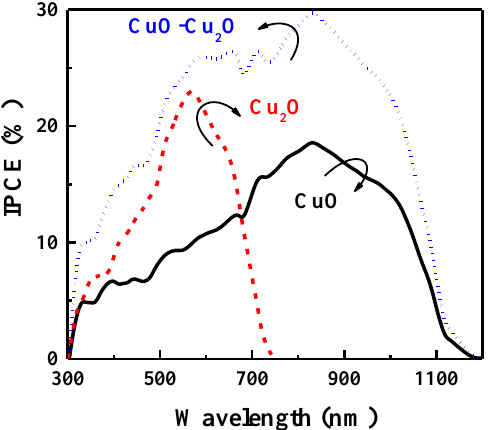
Figure 6. IPCE spectra of the CuO, Cu 2 O, and heterojunction CuO – Cu 2 O thin film photocatalysts.